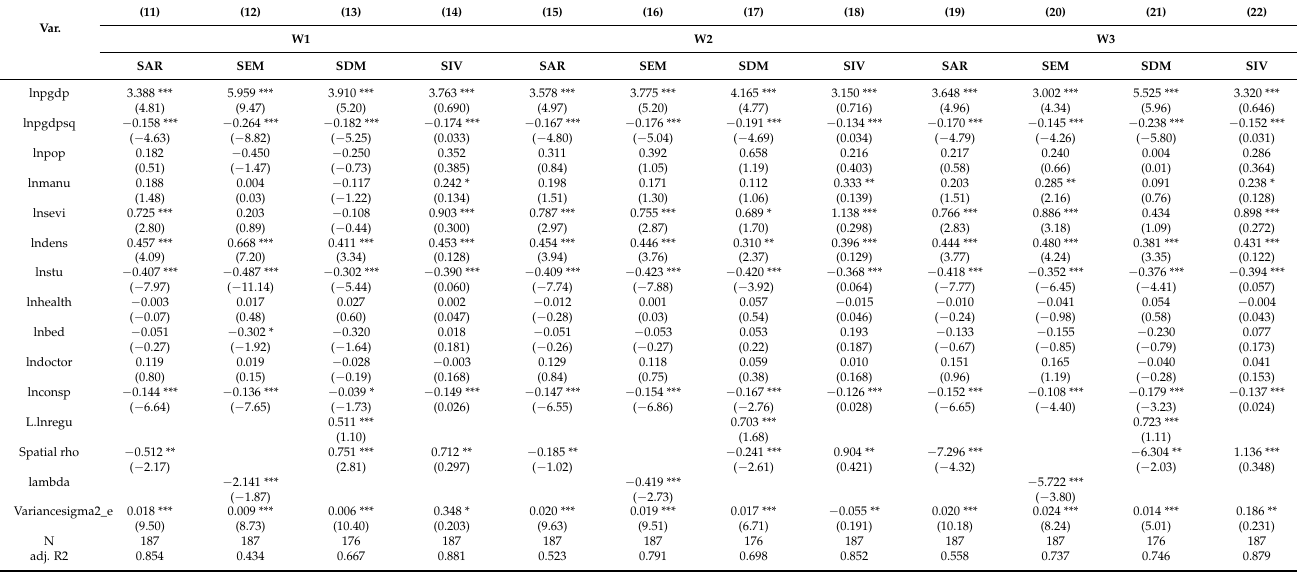
Table 4. The relationship between the economic development and environmental regulation (not the spatial